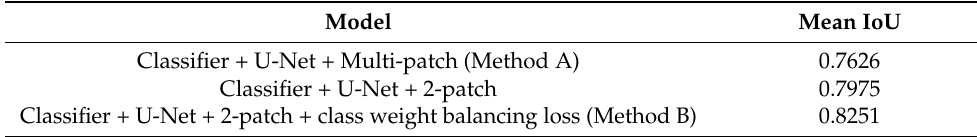
Table 2. Performance of the neural network using various settings reported as mean intersection over union.